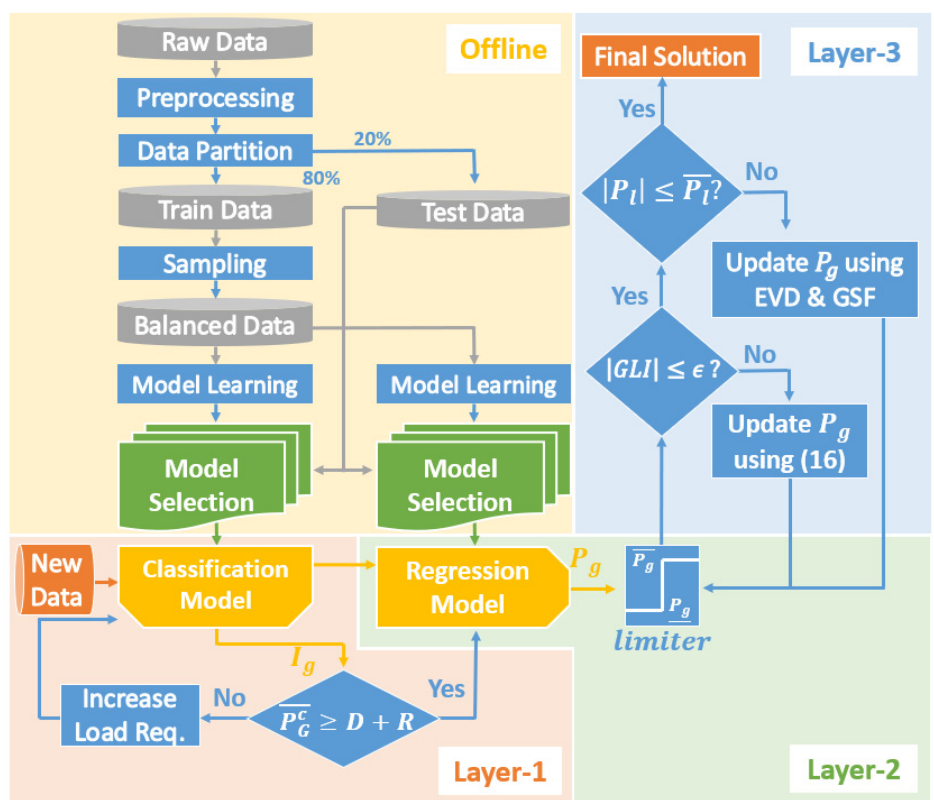
Figure 7. Three Layer Proposed SCUC